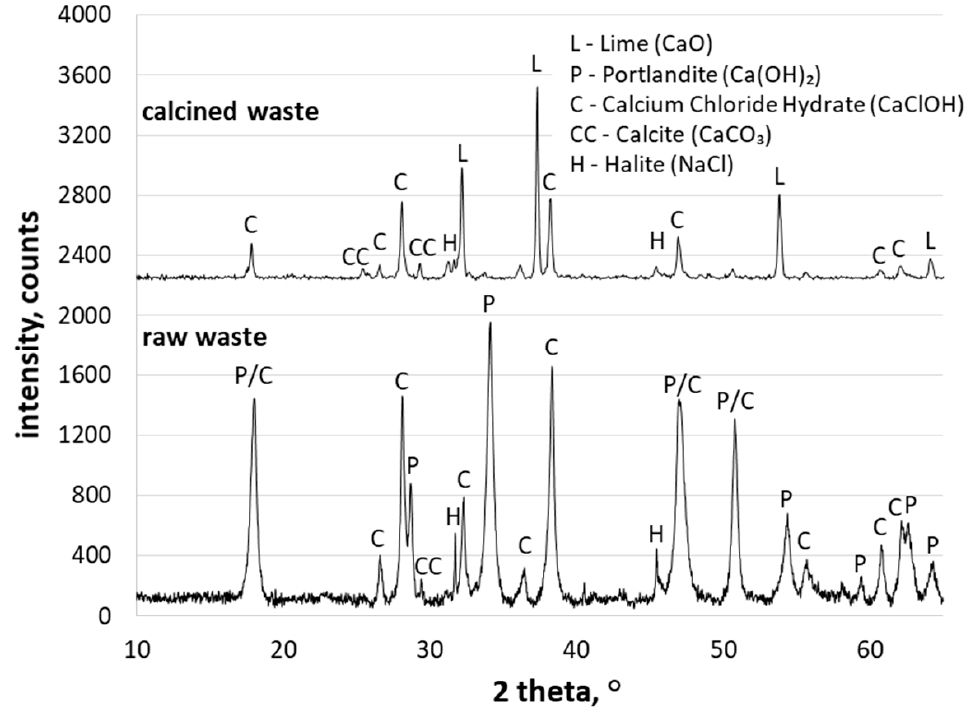
Figure 1. XRD patterns of raw and calcined waste.